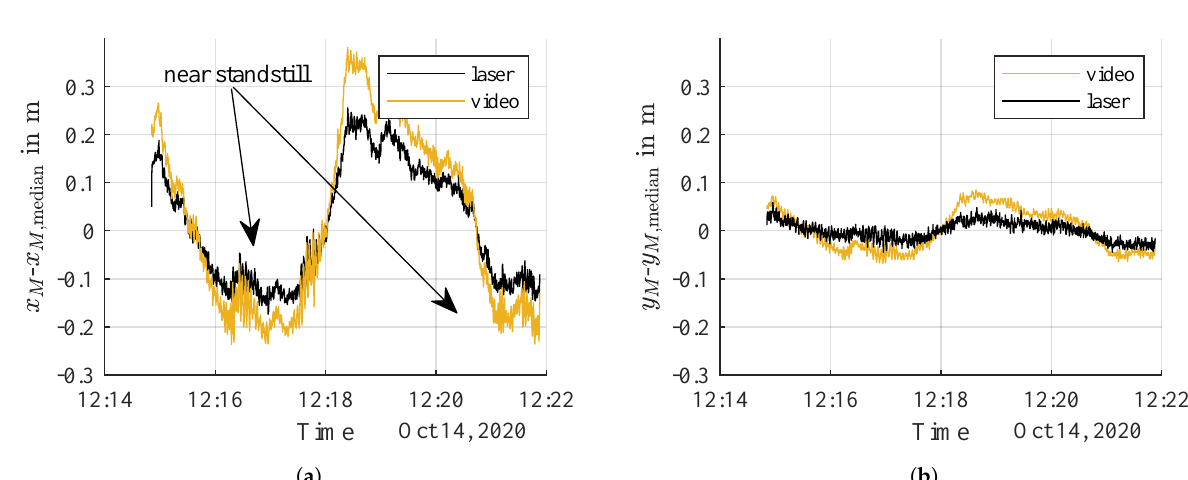
Figure 9. Tower movement in the lateral and axial direction measured by the laser scanner and video recording during low wind conditions. ( a ) Tower movement in the lateral direction ( x M ). ( b ) Tower movement in the axial direction ( y M ).